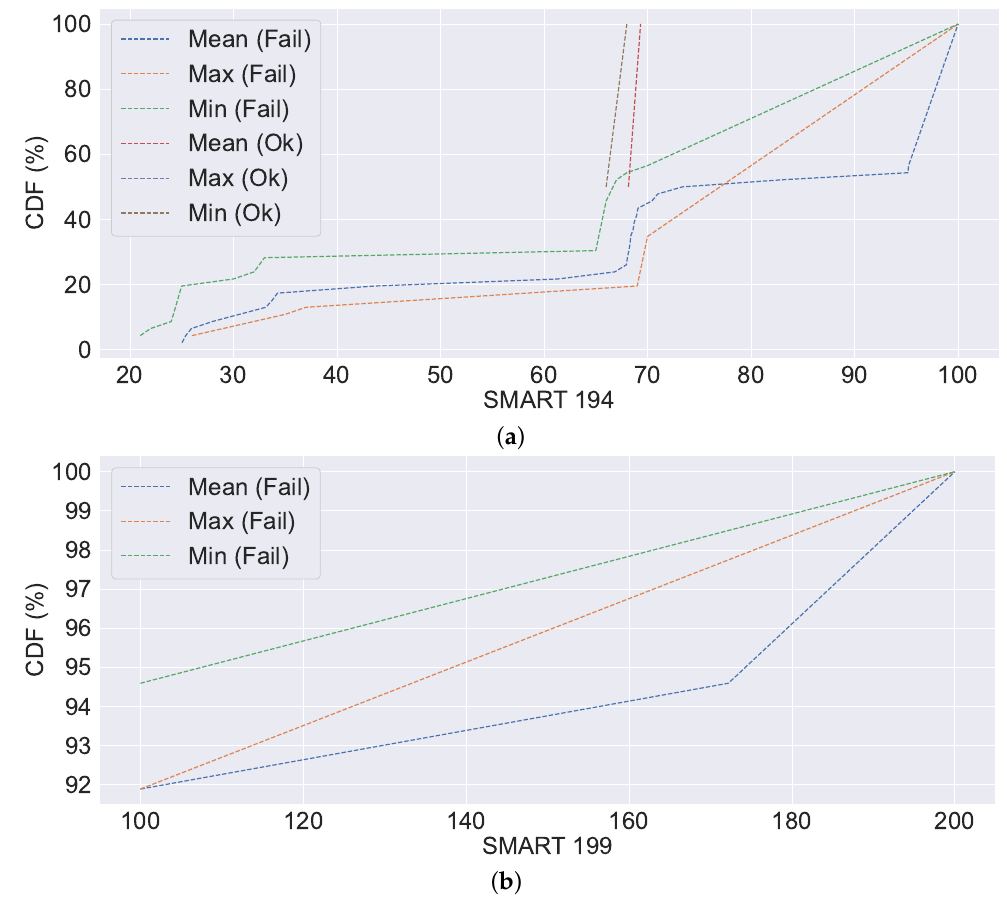
Figure 15. Visualisation of the CDF of SMART 194 and SMART 199. ( a ) CDF of SMART 194; ( b ) CDF of SMART